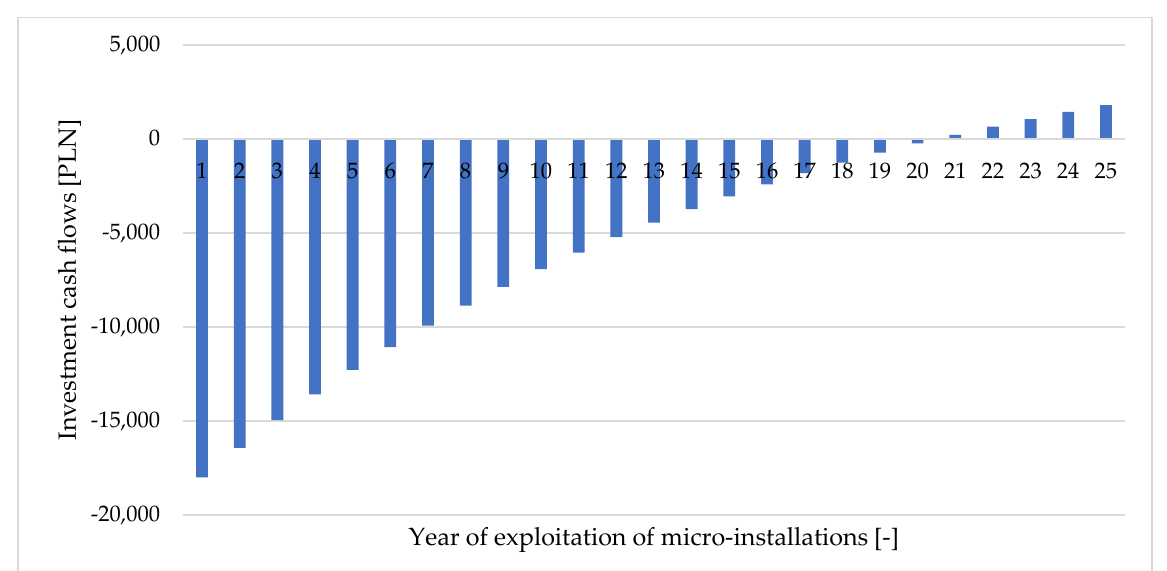
Figure 11. Graph showing the cash flow of the investment as a function of time of its operation for the net-billing system based on hourly prices and a 50% self-consumption level.